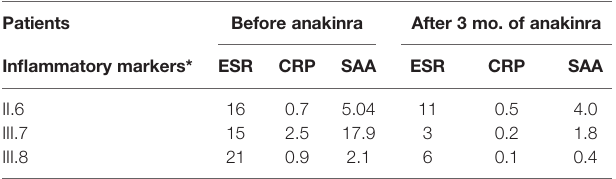
TABLE 2 | In fl ammatory markers